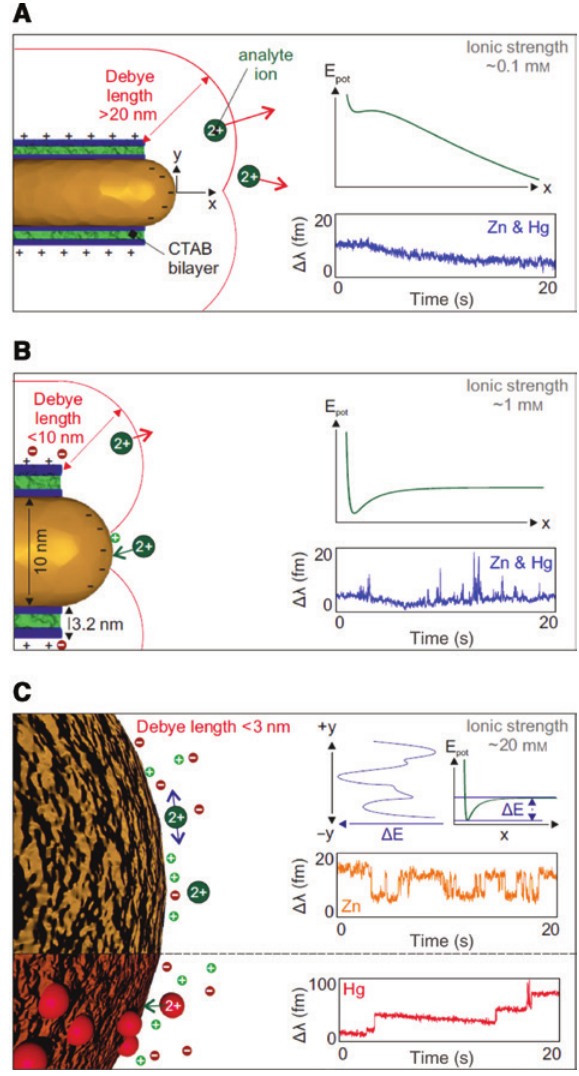
Figure 15: Optical observation of single atomic ions Zn 2 + and Hg 2 + interacting with plasmonic nanorods in solution. The detection signal has been boosted with optical microcavities. Three different interaction regimes were observed: (A) complete screening of ion-nanorod interactions with no spikes or steps at low ionic strengths, (B) restriction of the attractive region with temporally short interactions at roughly 1 mm ionic strength, and (C) Zn analyte ions confined for longer periods of time in the local minimum and Hg permanently bound at high ionic strengths. Reprinted from